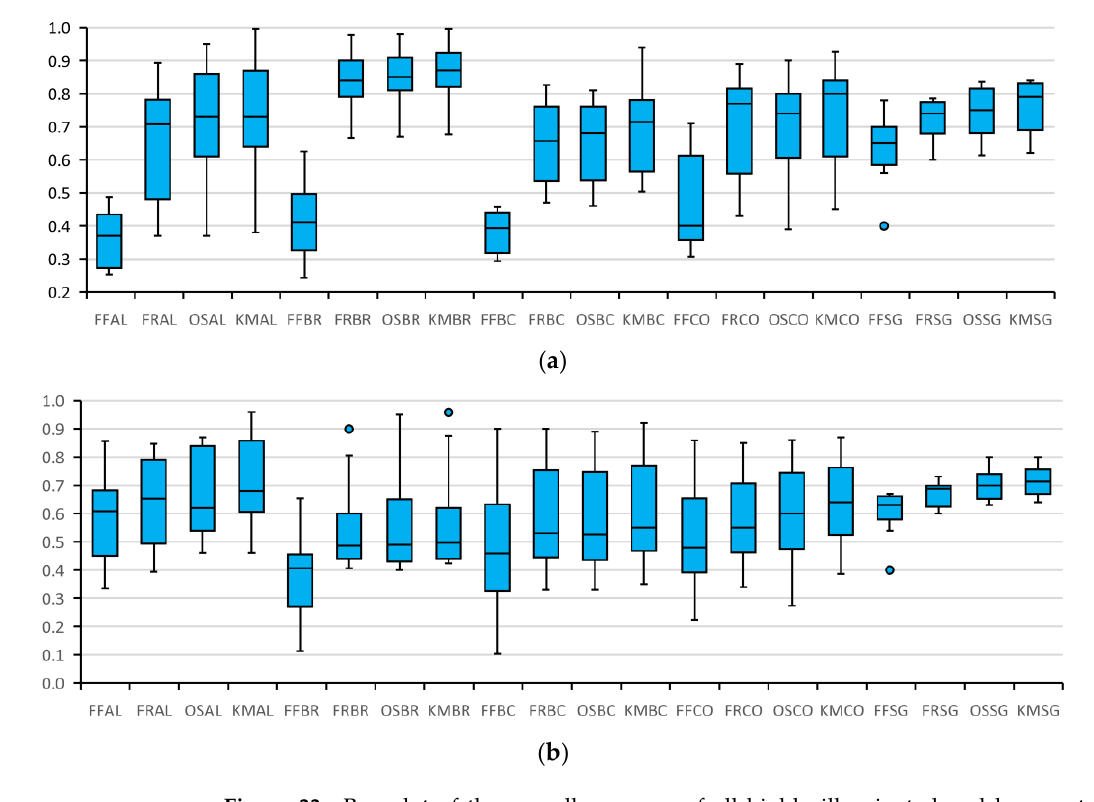
15 of 22 Figure 30. Validation tests of the proposed segmentation algorithms using highly illuminated and low contrast seagrass image (9) from Figure 27 as example of three categories: ( a ) original image; ( b ) ground truth image; ( c ) FF result; ( d ) FR result; ( e ) OS result; ( f ) KM result. Dark green: seagrass, gray: corals, and yellow: sediments. ( a ) ( h ) Figure 31. Validation tests of the proposed segmentation algorithms using low illuminated and high contrast seagrass image (1) from Figure 28 as example of two categories: ( a ) original image; ( b ) ground truth image; ( c ) KM result; ( d ) KMAc result; ( e ) FFCr result; ( f ) FRCr result; ( g ) OSCr result; ( h ) KMCr result. Dark green: seagrass, and yellow: sediments. ( a ) ( h ) Figure 32. Validation tests of the proposed segmentation algorithms using low illuminated and high contrast seagrass image (16) from Figure 28 as example of three categories: ( a ) original image; ( b ) ground truth image; ( c ) KM result; ( d ) KMAc result; ( e ) FFCr result; ( f ) FRCr result; ( g ) OSCr result; ( h ) KMCr result. Dark green: seagrass, gray: corals, and yellow: sediments. Results presented in Figure 33 and Table 1 correspond to results in Figures 3, 9, 15,